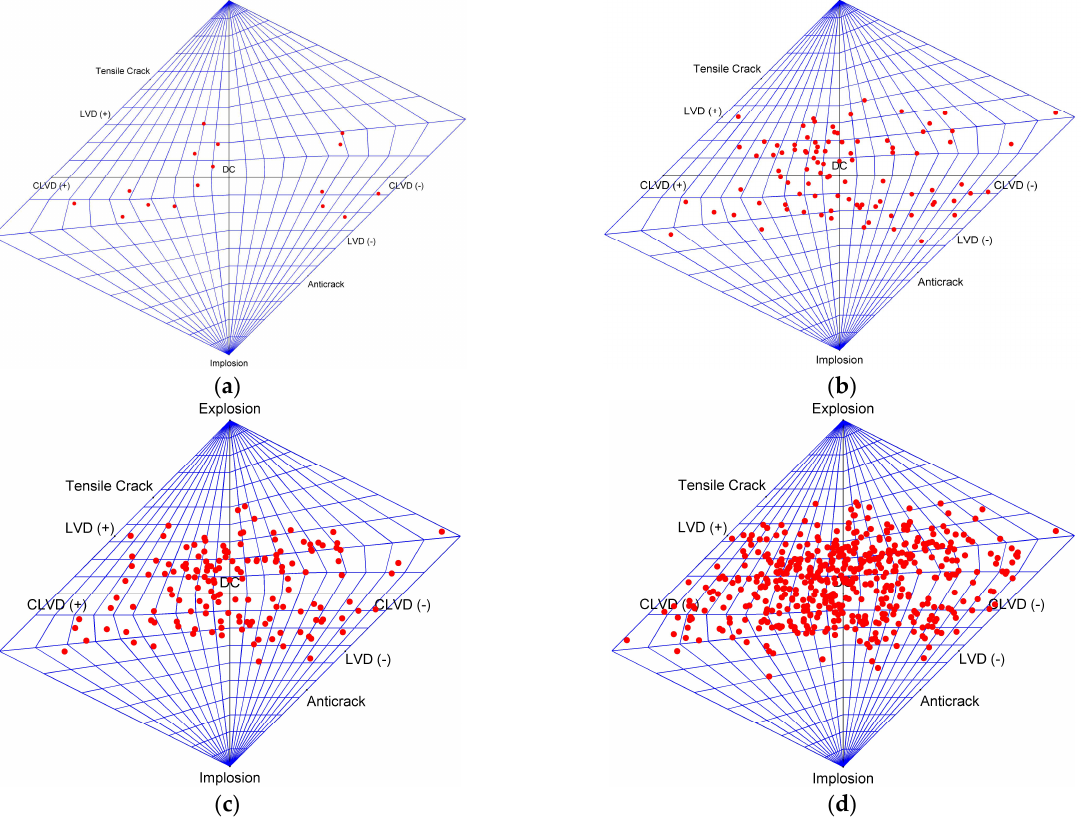
Figure 9. Hudson T–K locations of source models from ( a – d ) . From Figure 9, at the four stages of loading, total of 15, 77, 65, and 417 AE events are recorded, respectively. The distribution of the AE events is relatively scattered, and most of them are distributed in the shear area. At stages (a) and (b), 15 and 77 events are gen- erated, respectively, with magnitudes of between −6.68 and −5.3. The corresponding stresses at the end of these two stages are 5.32 MPa and 7.4 MPa, which are approximately 68% and 94% of peak stress, respectively. The AE events during this period are mainly dominated by the water pressure. At stages (c) and (d), the axial stress gradually reaches the peak strength of the coal. During this period, the effect of the axial stress is far greater than that of the water pressure, and the number of AE events sharply increases (mainly shear failure), which leads to instability of the sample.